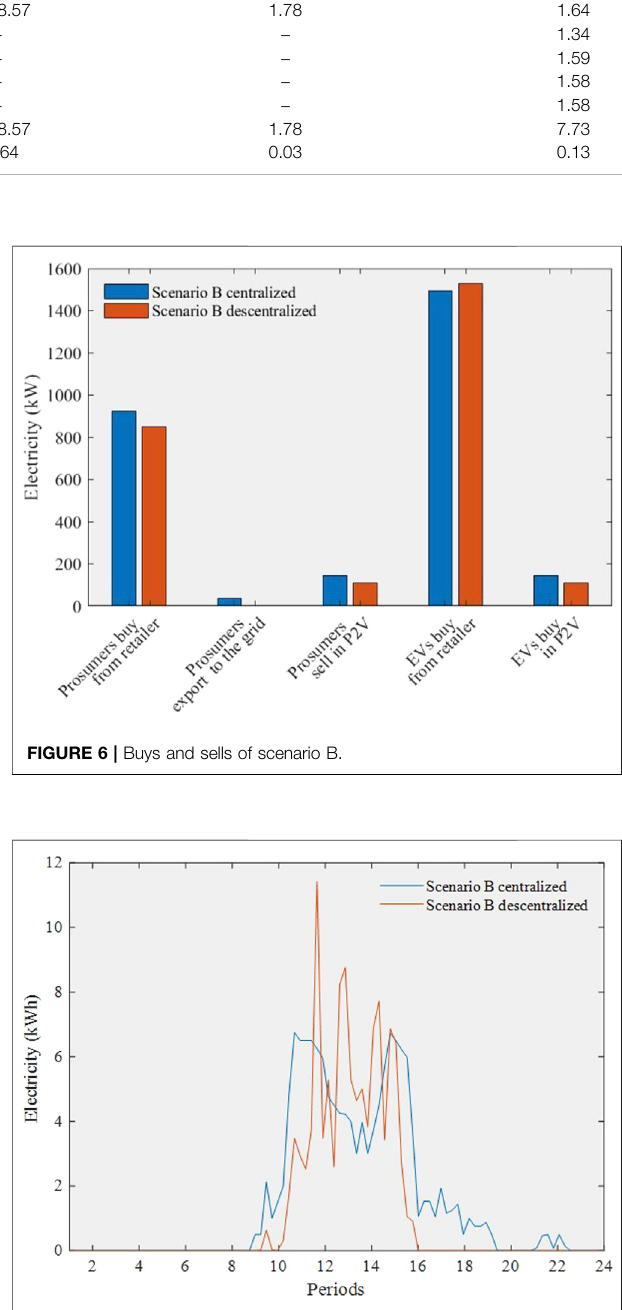
FIGURE 7 | Buys and sells of scenario